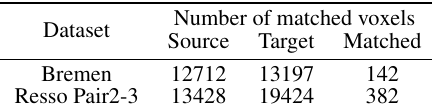
Table 2. Matched voxels in the experimental datasets.